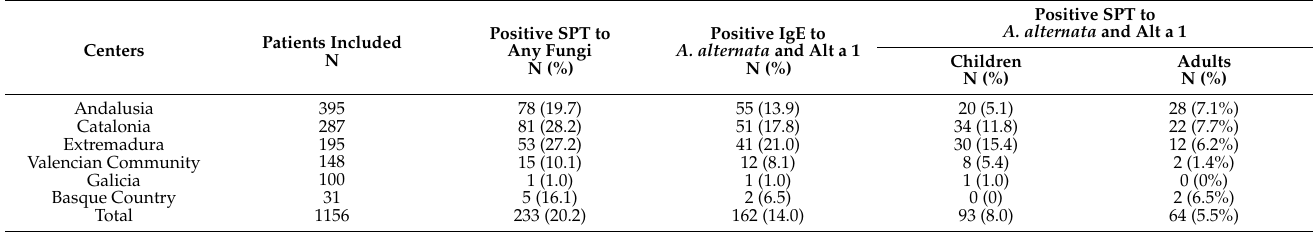
Table 3. Patients sensitized to fungi and Alternaria alternata or Alt a 1 by bioclimatic regions.